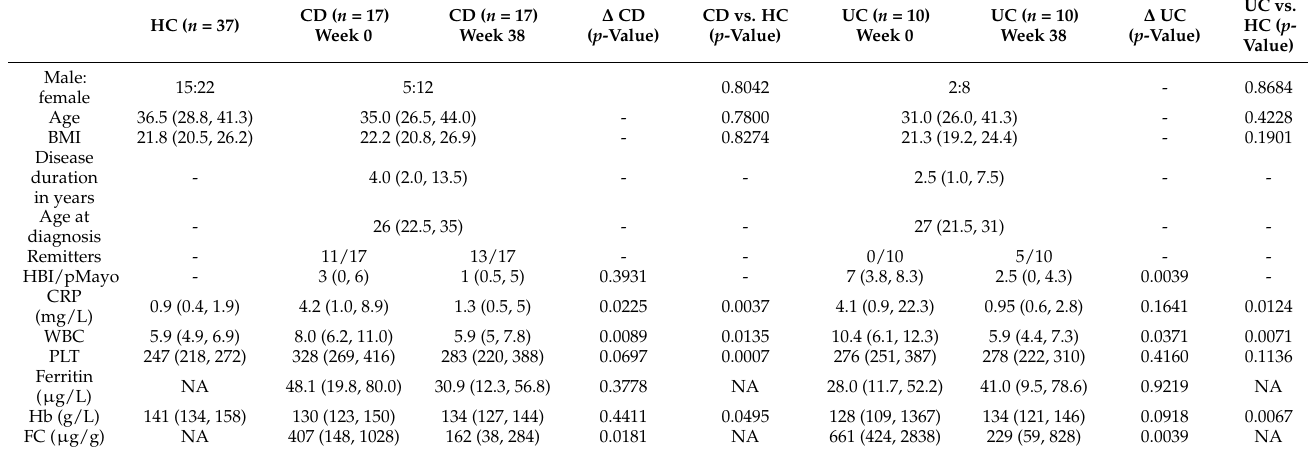
Table 1. Comparison of anthropometric and clinical parameters in healthy controls and patients with IBD included in the gut microbiome analysis at baseline (week 0) and at the endpoint (week 38). Multiple comparisons between groups were evaluated by the Kruskal–Wallis test followed by Dunn’s multiple comparison test. Changes during anti-TNF therapy (week 0 vs. week 38) were evaluated by Wilcoxon matched pairs signed-rank test. Medians are reported with the first and third quartiles in parentheses. Abbreviations: CD, Crohn’s disease; UC, ulcerative colitis; HC, healthy control; BMI,